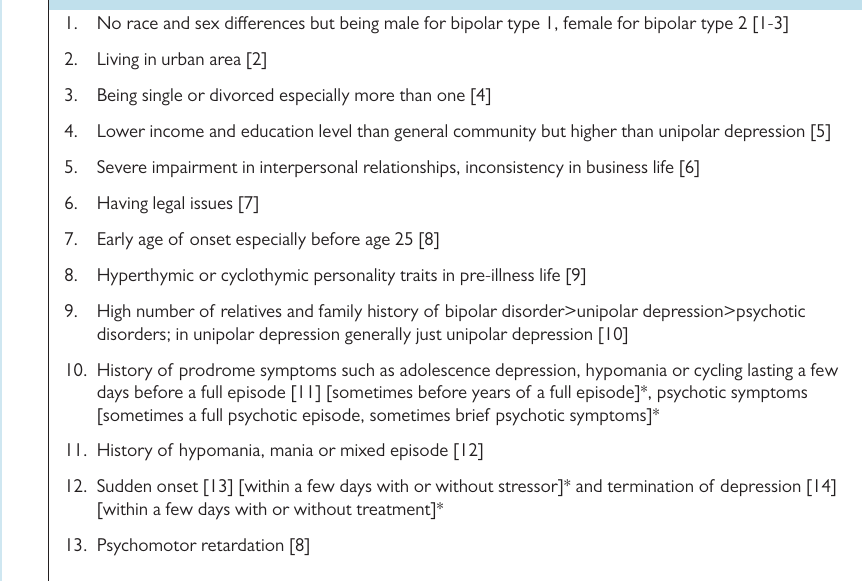
Table 1. Clinical Characteristics in Favour of Bipolarity in